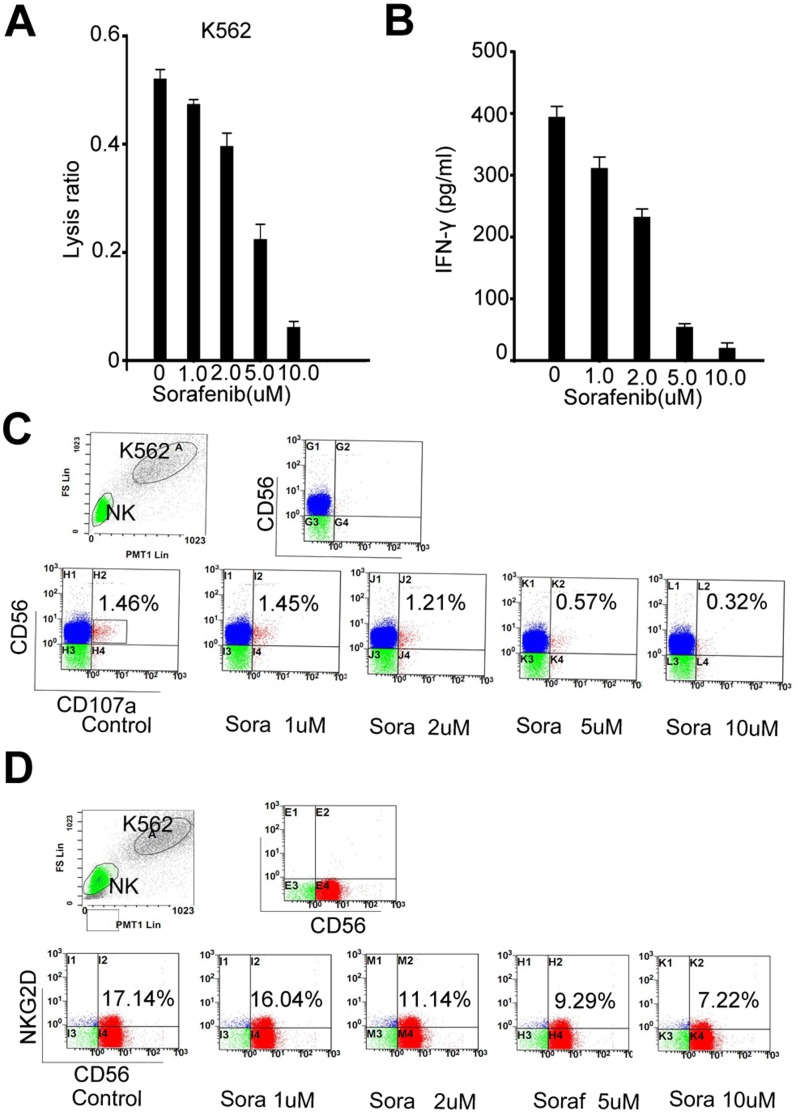
Sorafenib impaired the reactivity of isolated human NK cells in vitro.(A) Sorafenib reduced the lysis ratio of NK cells in response to K562 cells (E:T = 30∶1) in a dose-dependent manner. (B) Sorafenib decreased the production of IFN-γ in NK cells when cocultured with K562 at the ratio of 3∶1 for 12 h. (C) Sorafenib reduced the expression of CD107a in NK cells mixed with K562 cells at the ratio of 3∶1 for 2 h. Representative flow cytometry dot plots were showed. (D) The expression of NKG2D by NK cells was also reduced when they were mixed with K562 cells at the ratio of 3∶1 for 8 h. Representative flow cytometry dot plots were showed.